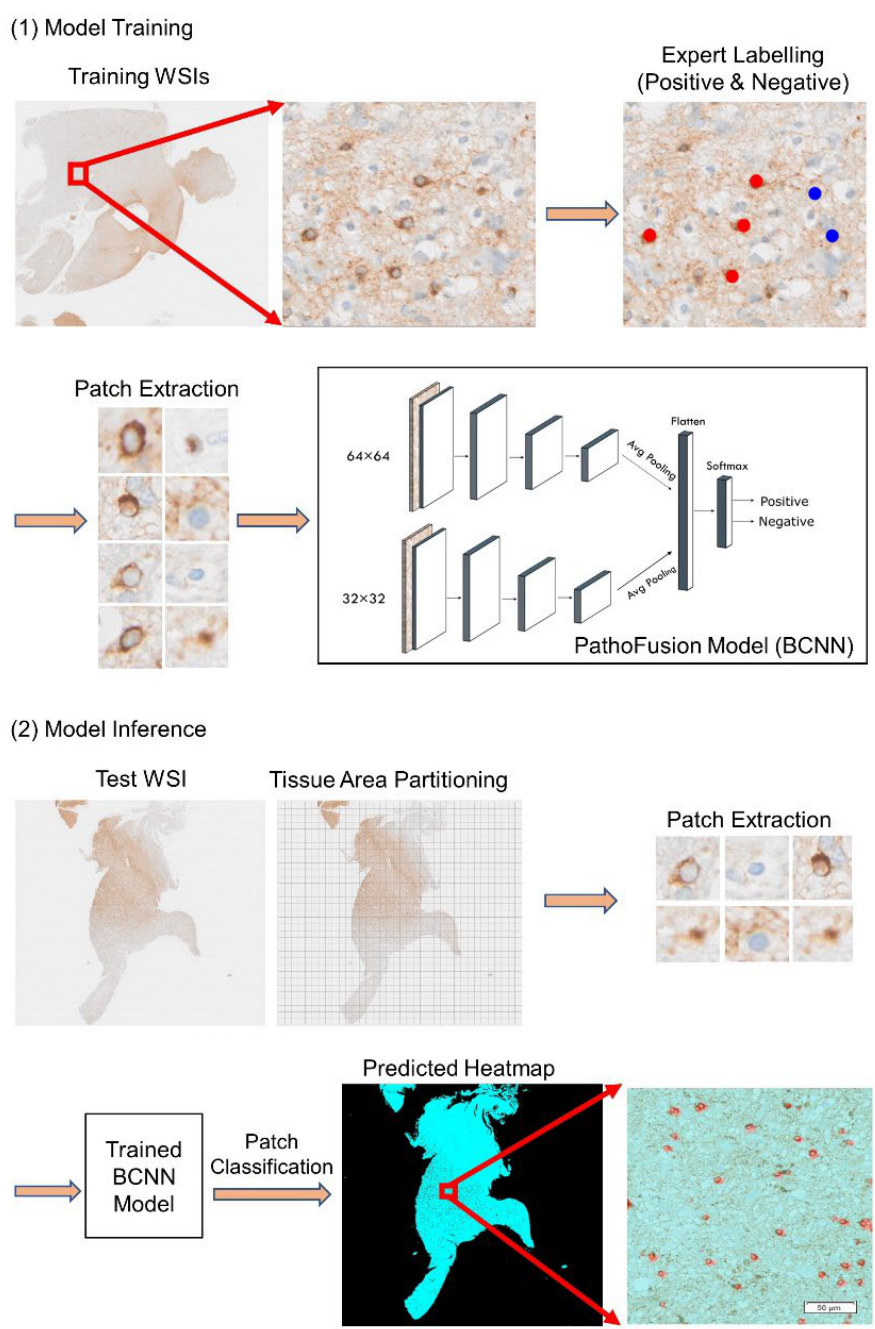
Figure 1. Illustration of the extended PathoFusion framework used for the analysis of cell profiles in whole-slide images (WSI). Slides were subjected to immunochemistry for CD276, followed by brief hemalum counterstaining. ( 1 ) Model training: Patches were extracted from a WSI in line with specialist (consultant neuropathologist) annotations and passed to the bifocal convolutional network (BCNN). ( 2 ) Model inference: Following partitioning of the test image (the grid size shown is not to scale and is for illustration purposes only), extracted patches are provided to the trained BCNN model for classification and the prediction results are converted into the corresponding heatmaps (the pseudo-colour red marks recognized cells). Scale bar: microns.